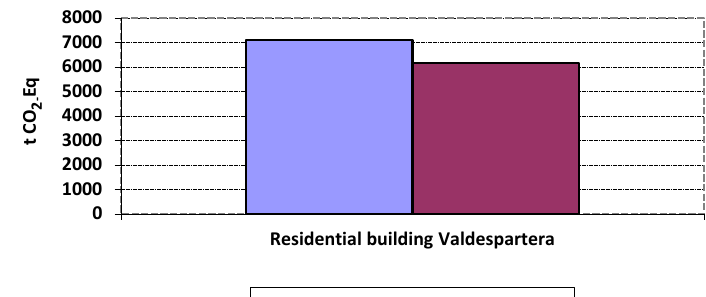
Figure 4. Comparison of the global warming potential impact (in equivalent t of : tCO -Eq) in the building analyzed using the complete LCA and the simplified CO 2 2